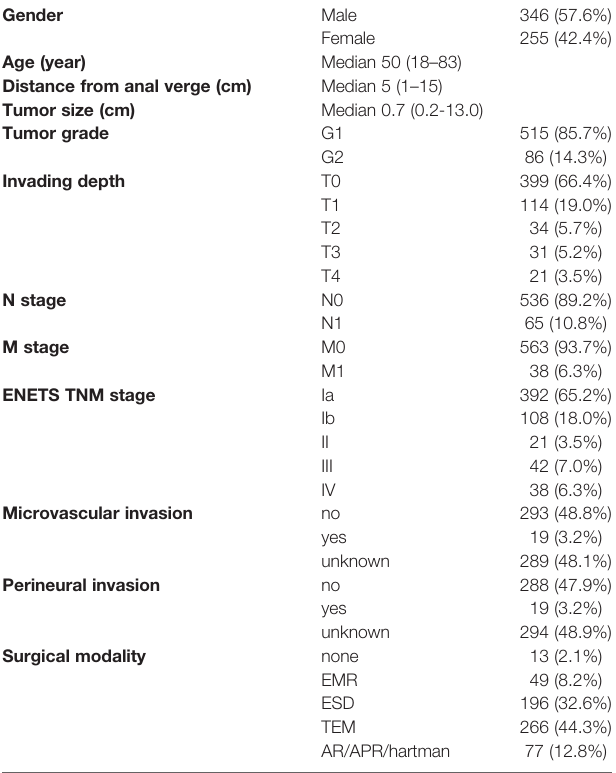
EMR, Endoscopic Mucosal Resection; ESD, Endoscopic Submucosal Dissection; TEM, Transanal Endoscopic Microsurgery; AR, Anterior Resection; APR, Abdomen Perineal Resection.